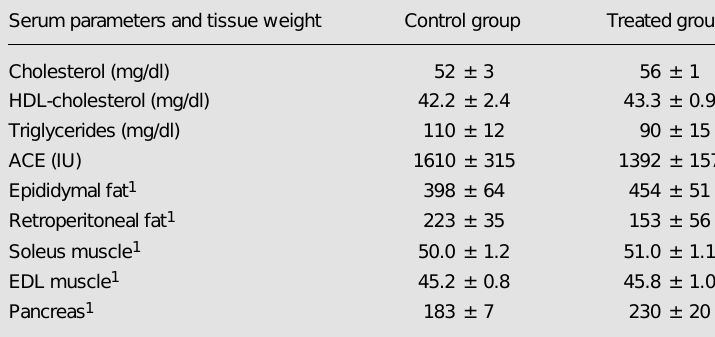
Table 3 - Serum parameters and tissue weight of streptozotocin-diabetic rats after oral treatment with a decoction of Eugenia jambolana for 17 days. The control group of 10 rats received no decoction, while the treated group of 10